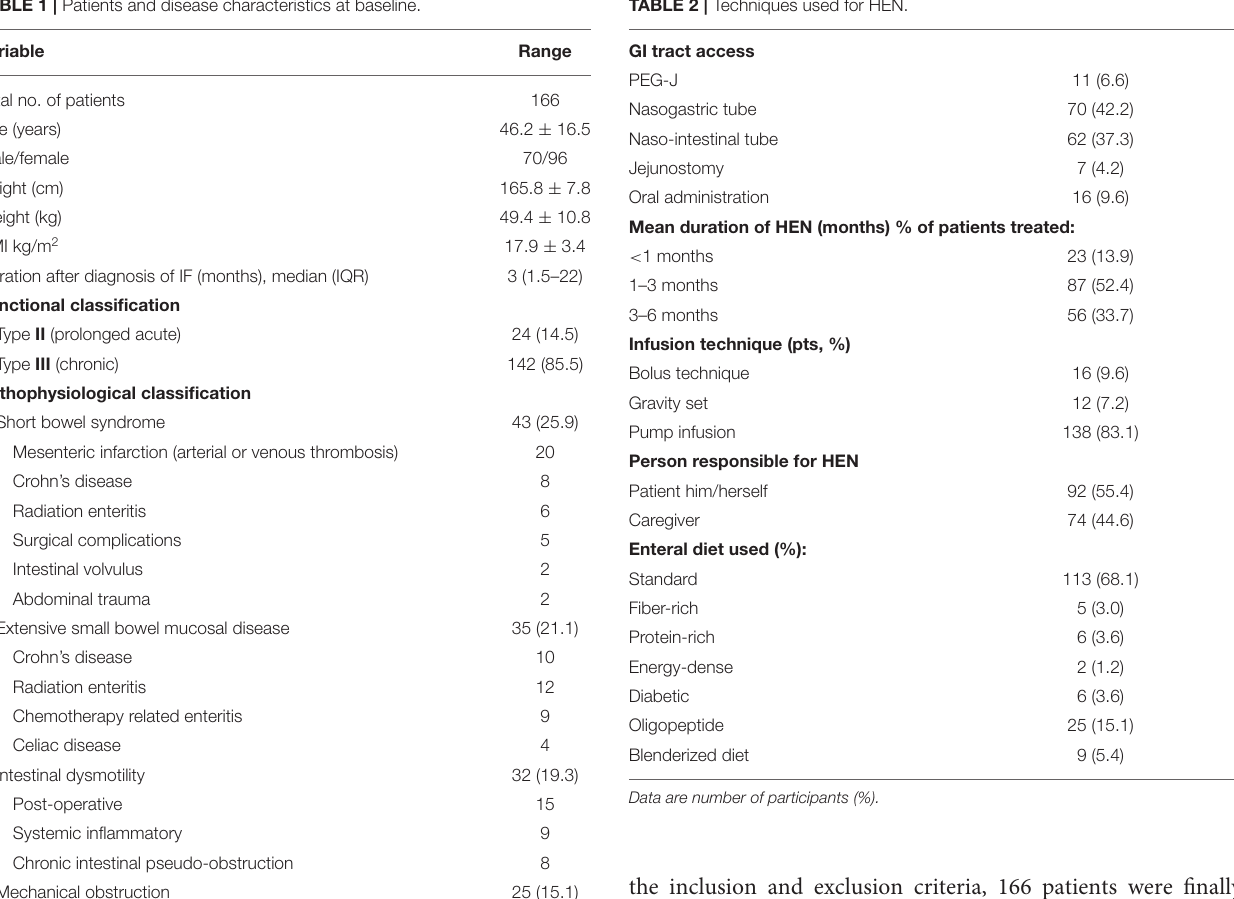
TABLE 1 | Patients and disease characteristics at